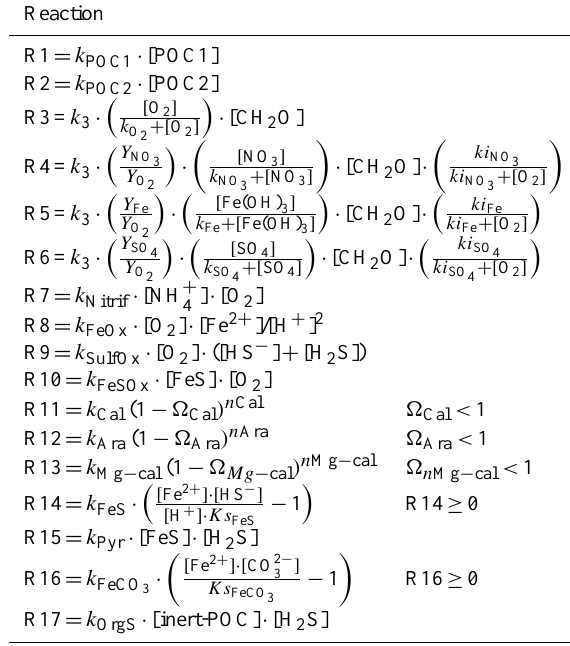
Table 4. Kinetic rate